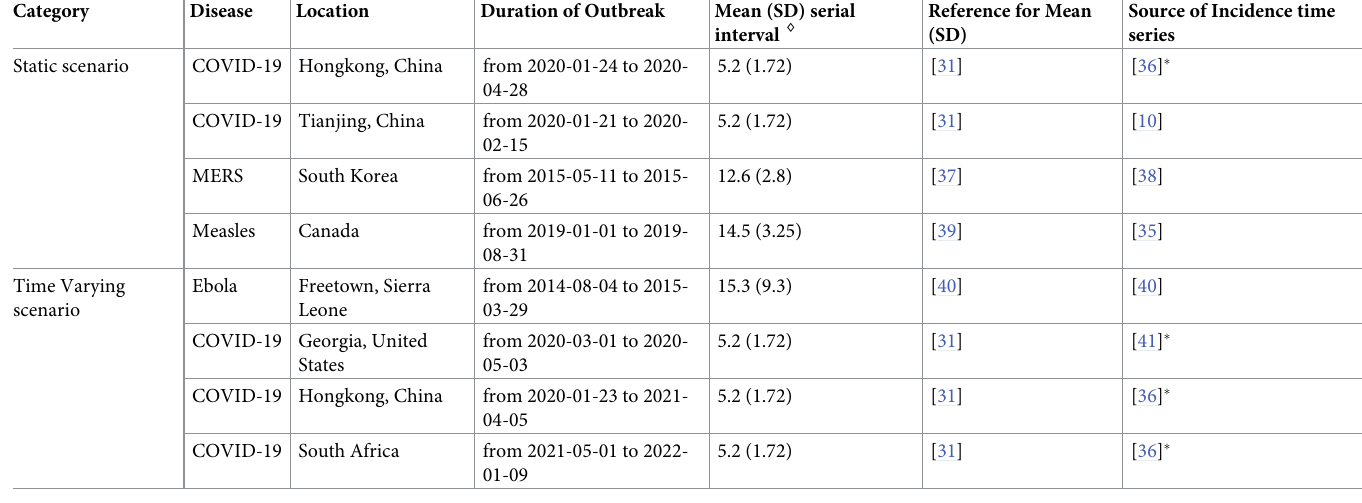
Table 1. Description of historic epidemic data